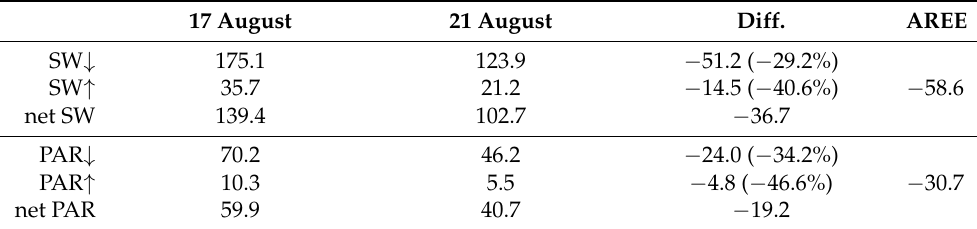
Table 2. Irradiances measured at THAAO on 17 and 21 August and their difference for SZA = 78 ◦ and AOD = 0.63; all the values are in [Wm − 2 ] except for AREE which are in [Wm − 2 AOD − 1